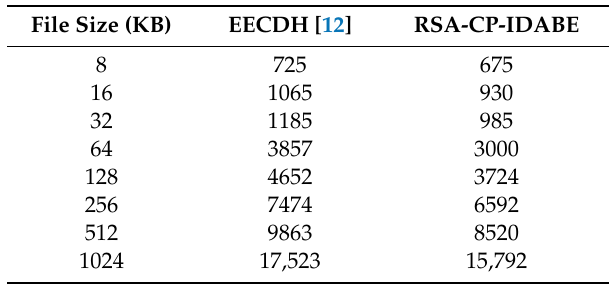
Table 4. Execution time vs. file size for RSA-CP-IDABE & EECDH.